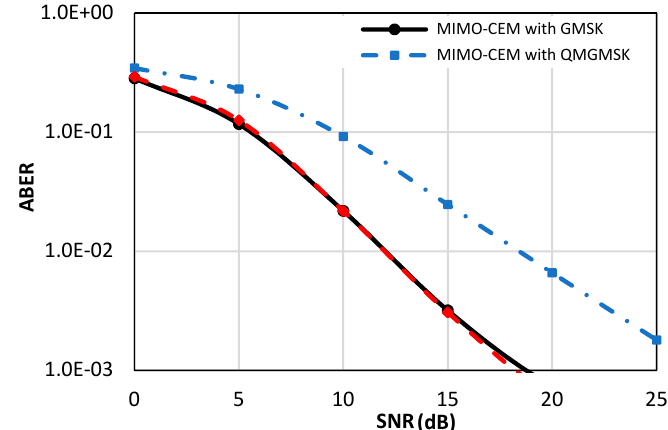
Figure 7. The ABER performance of the proposed MIMO-OSP-MSK compared to the ABER of the conventional multiple-input multiple-output constant envelope modulation (MIMO-CEM) system with GMSK and QMGMSK modulation schemes [32,33].